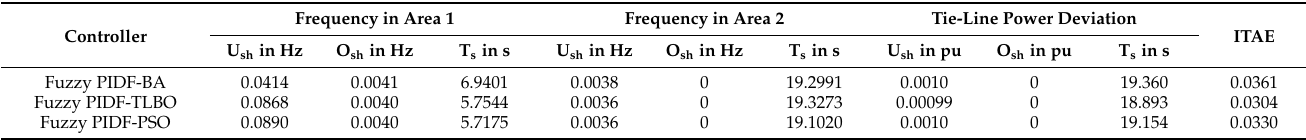
Figure 20. Tie-line power deviation ( ∆ P tie ). Table 20. Frequency response performances with different controllers.